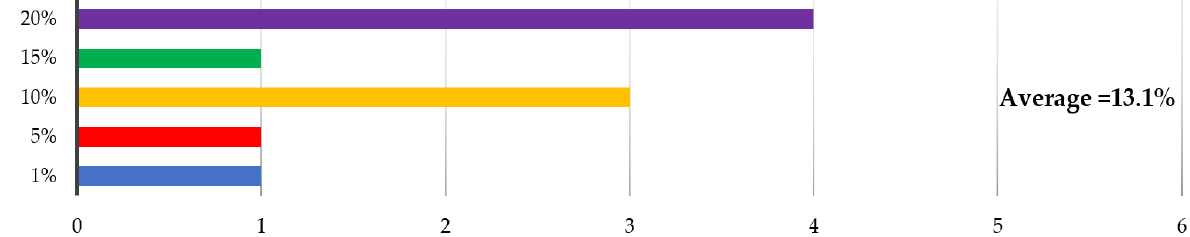
Figure 14. Responses to the question: “In your opinion, what should be the ideal percentage of people assigned to BIM management/coordination within the overall team of the lead-appointed party? For example, 1 person in a 10-member team = 10%” .